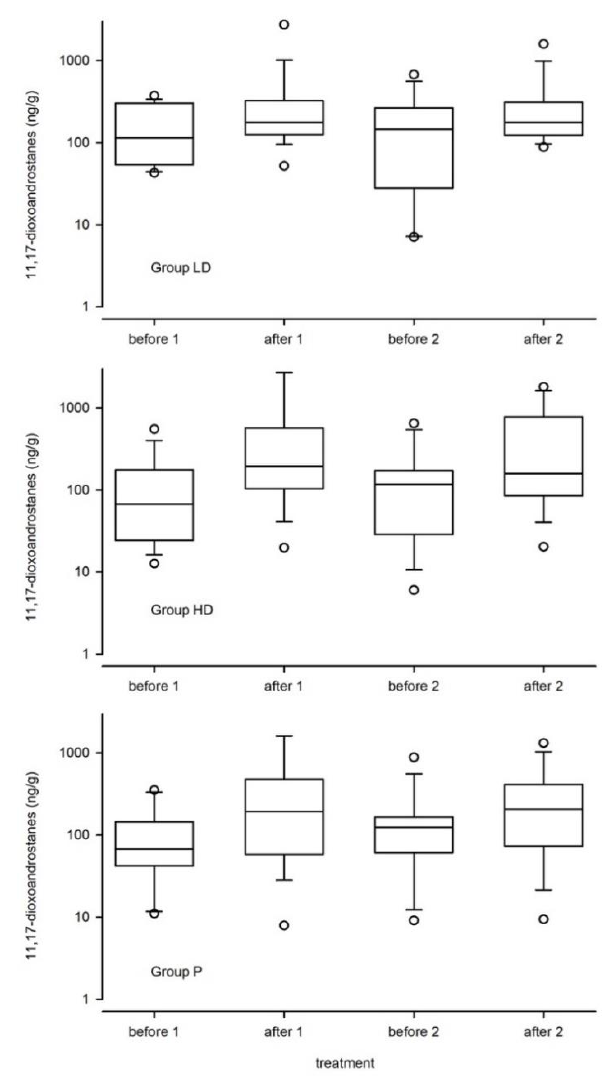
Figure 2. E ff ects of α -s1 casozepin in di ff erent doses (LD = low dose; HD = high dose; P = placebo) and times on fecal cortisol metabolites (11,17-dioxoandrostanes; note the logarithmic scale of the y- axes).